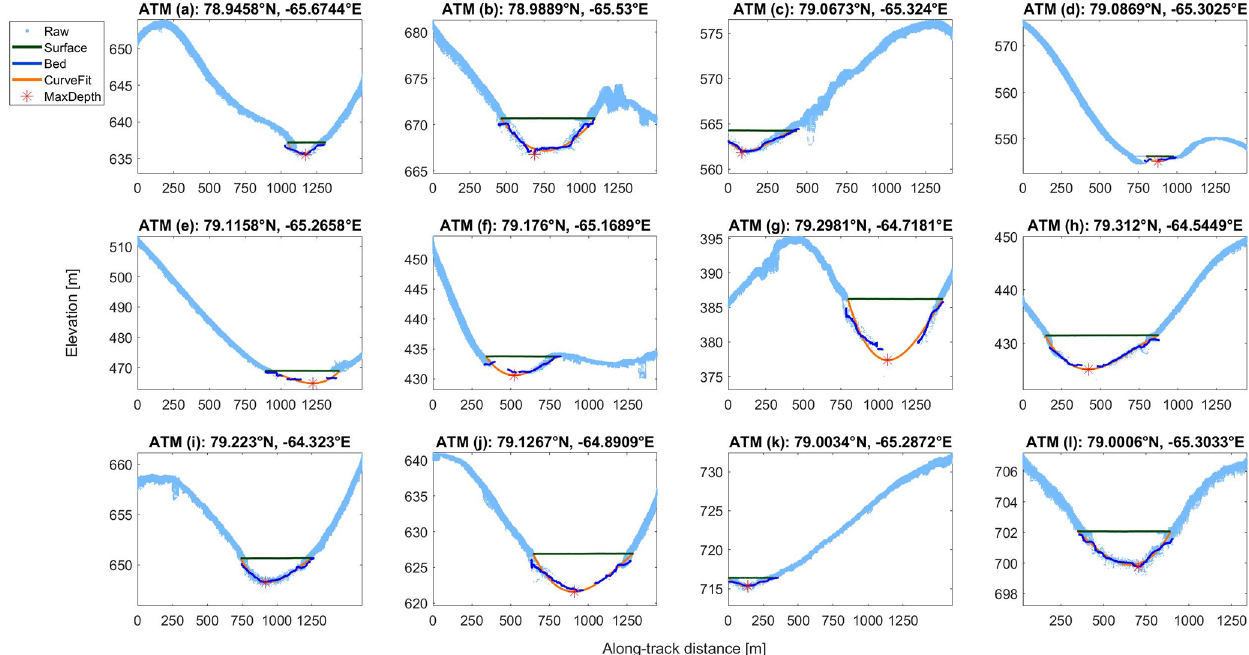
Figure 3. ATM lake profiles from 17 July 2017 fitted using lake surface–bed separation, including the raw ILATM1B product, the lake surface signal, the lake bottom signal, the polynomial- and spline-fitted bottom, and the point of maximum depth. Along-track distance is relative to the start of a data granule.